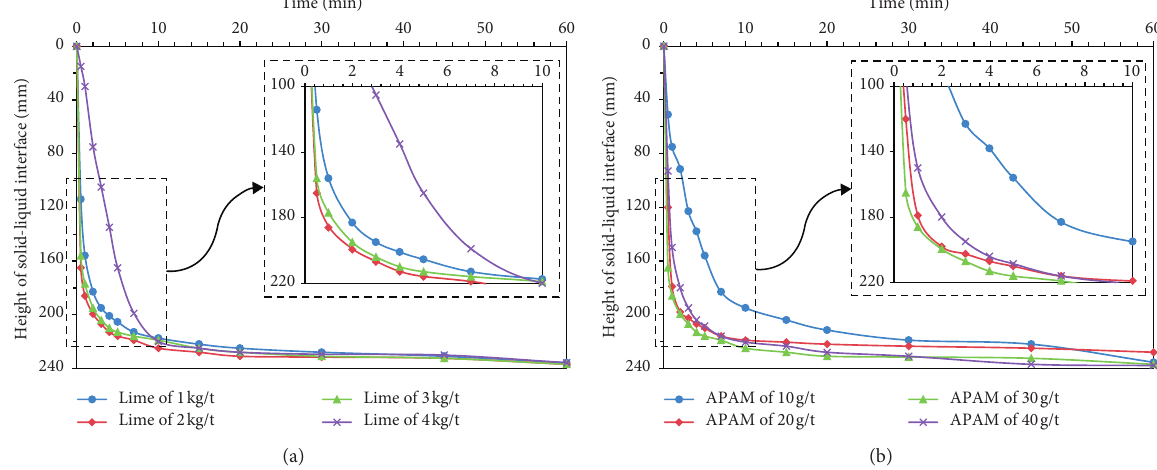
Figure 5: Height variation of the solid-liquid interface with time (a) when the dosage of APAM was 30g/t and the addition of lime changed from 1 kg/t to 4kg/t; (b) when the addition of lime was 2kg/t and the APAM changed from 10 g/t to 40